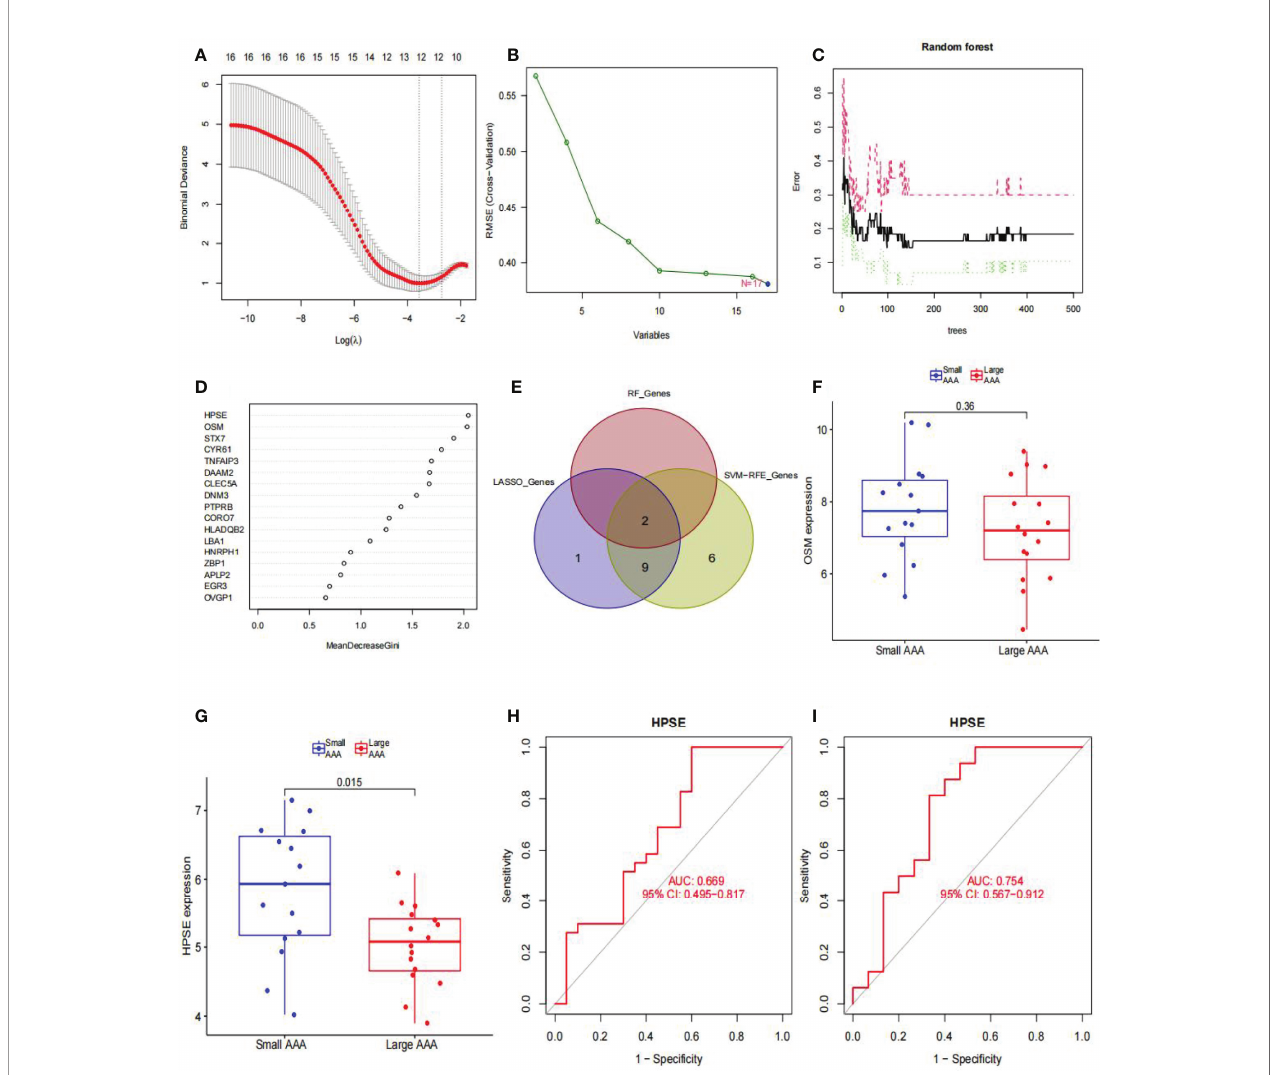
FIGURE 8 | Diagnostic indicators for large AAA screening and validation. (A) Fine-tuning the least absolute shrinkage and selection operator (LASSO) model ’ s feature selection. LASSO regression was used to narrow down the DEGs, resulting in the discovery of 12 variables as potential markers for AAA. The ordinate represents the value of the coef fi cient, the lower abscissa represents log ( l ), and the upper abscissa represents the current number of non-zero coef fi cients in the model. (B) A plot illustrating the process of selecting biomarkers using the support vector machine-recursive feature elimination (SVM-RFE) technique. The SVM-RFE technique was used to identify a subset of 17 characteristics from the DEGs. (C) The effect of the decision tree number on the error rate. The x-axis denotes the number of decision trees, while the y-axis shows the error rate. When approximately 200 decision trees are used, the error rate is generally steady. (D) The Gini coef fi cient method ’ s results in a random forest classi fi er. The x-axis displays the genetic variable, and the y-axis the signi fi cance index. (E) Venn diagram showing overlapping markers. (F) OSM mRNA expression in large AAA samples is not statistically signi fi cant (P > 0.05) when compared to small AAA samples in the GSE98278. (G) HPSE mRNA expression is signi fi cantly higher in large AAA samples than in small AAA samples in the GSE98278 (P < 0.05). ROC curves were constructed using publicly available data to assess the diagnostic accuracy of HPSE for large AAA. (H) GSE57691 has an AUC of 0.669. (I) GSE98278 had an AUC of 0.754. ROC, receiver operating characteristic; AUC, area under the ROC curve; AAA, abdominal aortic